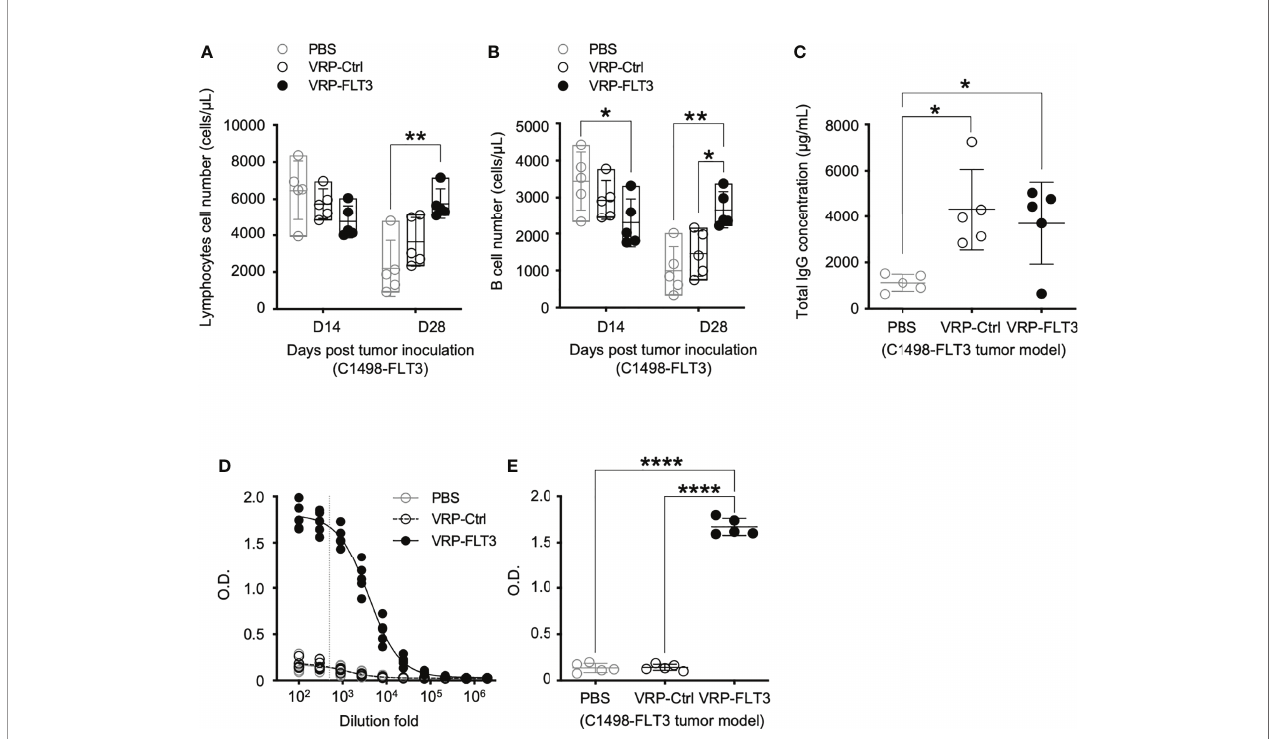
FIGURE 4 | VRP-FLT3 vaccination elicits a FLT3-speci fi c antibody response in a mouse leukemia model. Mice challenged with C1498-FLT3 tumor cells were vaccinated as described in Figure 1 . (A, B) Blood samples harvested on days 14 and 28 were analyzed by fl ow cytometry for the numbers of (A) lymphocytes and (B) CD19 + B cells. (C) Concentrations of total IgG and (D, E) levels of FLT3-speci fi c IgG in day 28 plasma samples were determined by ELISA. The titration curves (D) and O.D. values at 1:500 dilution (E) , indicated as the vertical dashed line in (D) , of anti-FLT3 IgG ELISA are shown. Each symbol represents an individual mouse (n=5 per group). Bars represent the mean ± SD. Statistical signi fi cance were determined by one-way ANOVA, *P<0.05, **P<0.01, ****P<0.0001. Data represents one of two independent